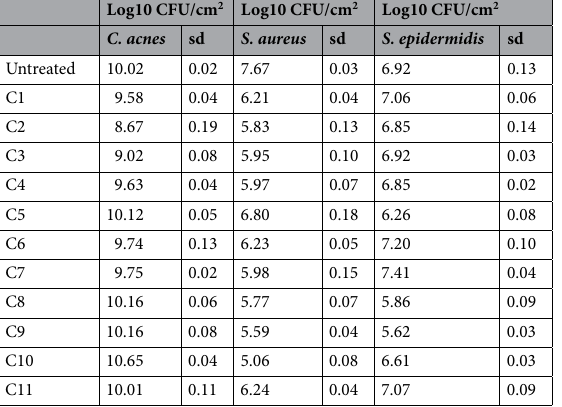
Table 2. Activity of the different combination of preservative tested on growth dynamic. Antimicrobial activity is expressed as Log10 CFU/cm 2 .